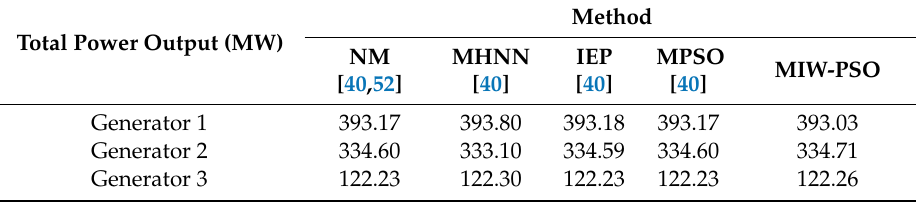
Table 2. Comparison of generator power output on the first case study.